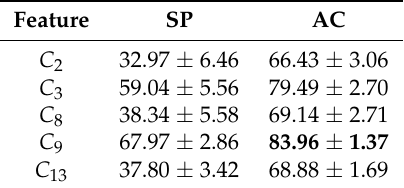
Table 7. Specificity (SP) and accuracy (AC) after testing data from all subjects with threshold T 2